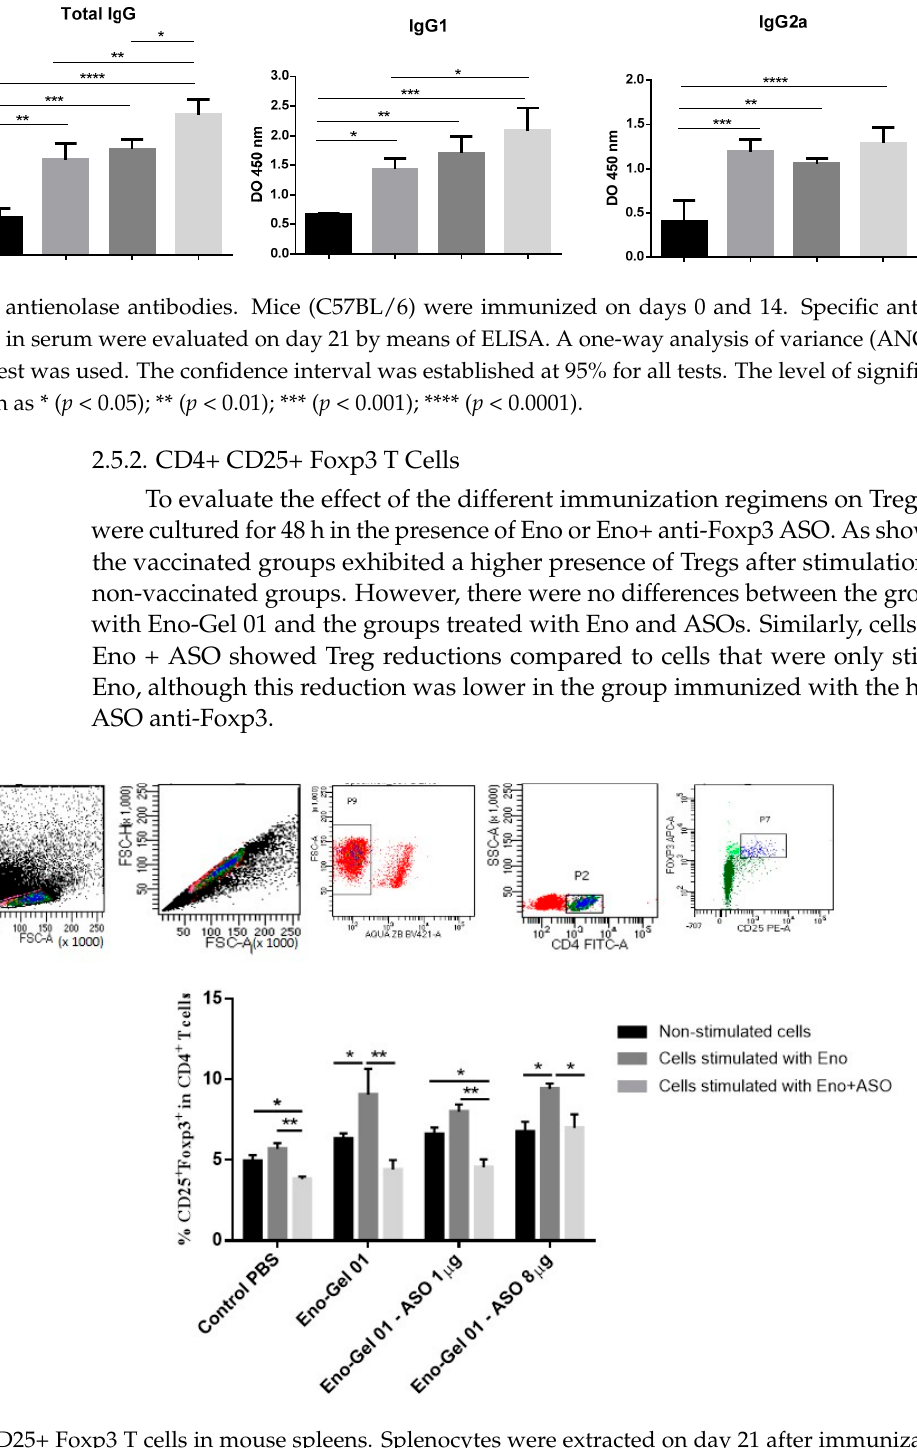
Figure 6. CD4+ CD25+ Foxp3 T cells in mouse spleens. Splenocytes were extracted on day 21 after immunization, then they were stimulated for 48 with Eno of S. schenckii or with Eno + ASO anti-Foxp3. Treg % was evaluated by means of flow cytometry. Top panel shows the gates strategy used in the study. A one-way analysis of variance (ANOVA) with Tukey’s post hoc test was used. The confidence interval was established at 95% for all tests. The level of significance and p -values are shown as * ( p < 0.05); ** ( p <